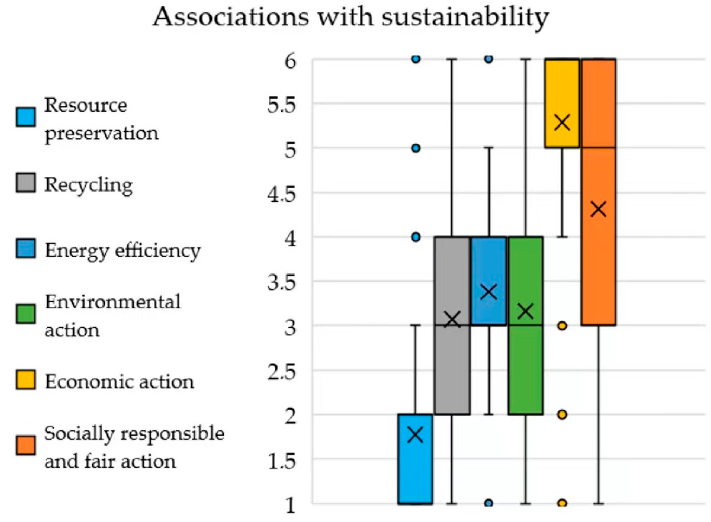
Figure 4. Respondents’ associations with sustainability with 1 = maximum and 6 = minimum.